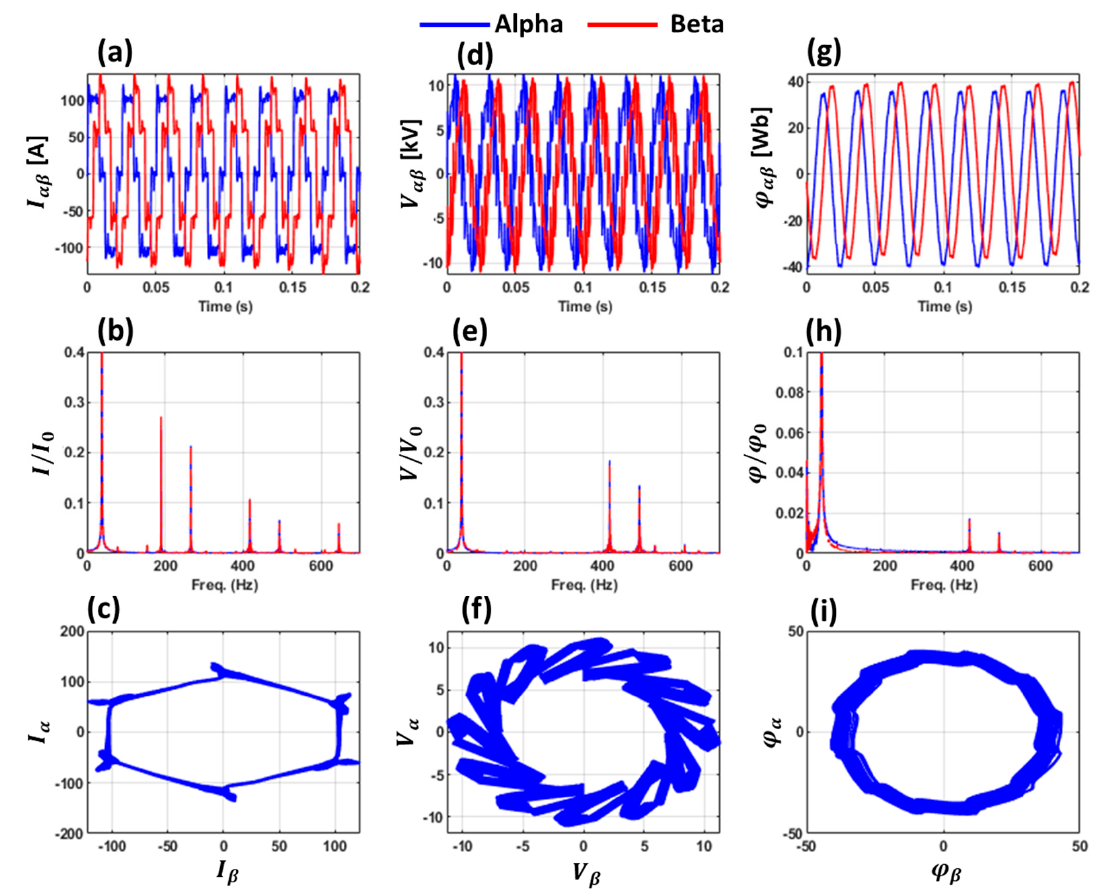
Figure 22. Sample simulation results of a 12/12-pulse LCI system at 40 Hz in alpha–beta reference frame: ( a ) motor current, ( b ) spectrum of motor voltage, ( c ) phasor of motor current, ( d ) motor voltage, ( e ) spectrum of motor voltage, ( f ) phasor of motor voltage, ( g ) stator flux, ( h ) spectrum of stator flux and ( i ) phasor of stator flux.